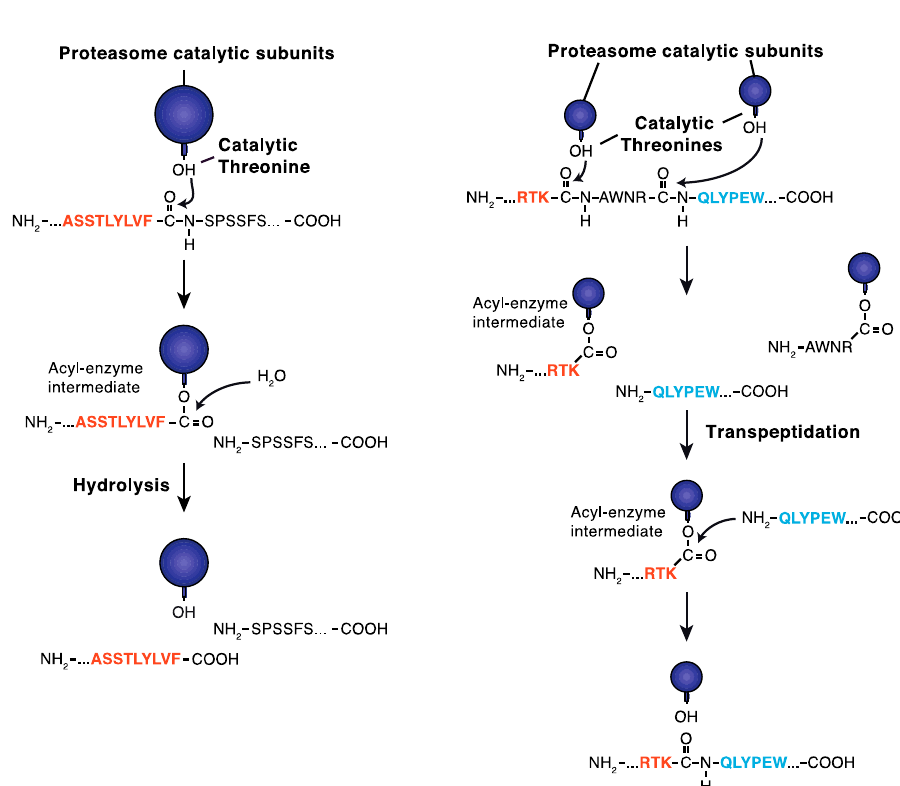
Figure 5. ( A ) Peptide bond hydrolysis. The hydroxyl group of the N-terminal threonine of the proteasome catalytic subunits attacks the carbonyl group of the peptide bond. This leads to the production of an acyl-enzyme intermediate in which the carbonyl group of the peptide fragment remains attached to the hydroxyl group of the N-terminal threonine of the proteasome by an ester link. To release the peptide fragment, a water molecule present in the catalytic chamber of the proteasome attacks the ester link between the peptide and the threonine residue, restoring the hydroxyl group of the catalytic threonine and producing the C-terminal end of the peptide. ( B ) Peptide splicing by the proteasome. The splicing of antigenic peptide RTK_QLYPEW derived from the gp100 is shown. Following formation of the acyl-enzyme intermediate involving the fragment RTK and the hydroxyl group of the N-terminal threonine of the proteasome, the free N-terminal amino-group of peptide QLYPEW present in the proteasome chamber attacks the acyl-enzyme intermediate, leading to the formation of the peptide RTK_QLYPEW composed of two peptide fragments originally distant in the protein.